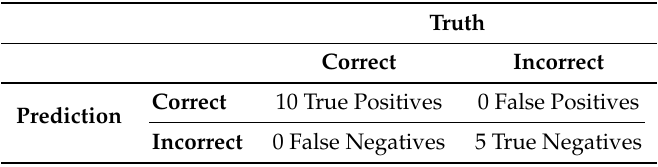
Table 5. Confusion Matrix for the Smile